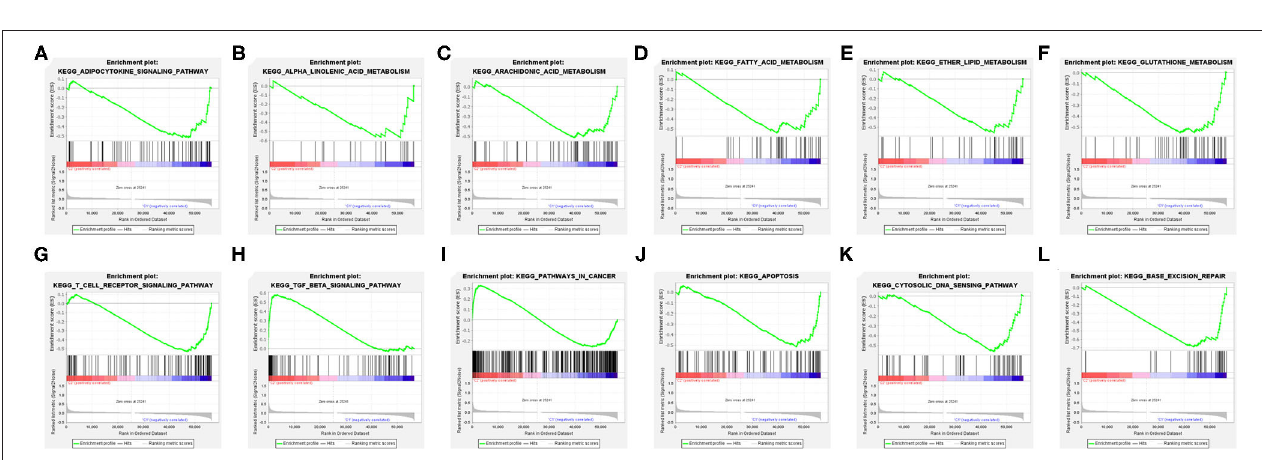
FIGURE 7 | Gene Set Enrichment Analysis (GSEA) between the clusters (A–L)